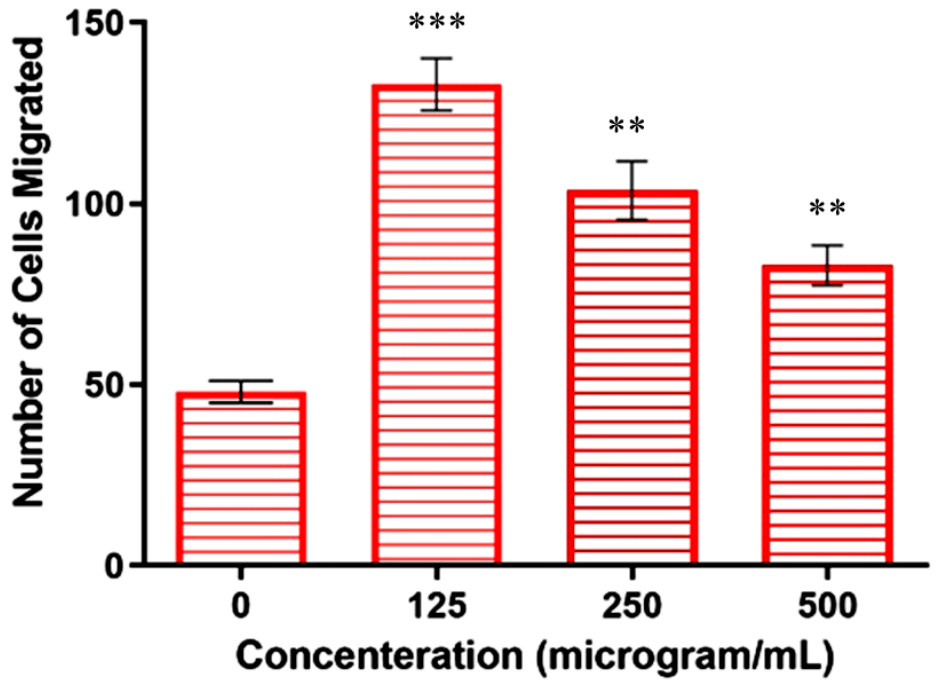
Figure 6. Copper–Schiff base complex inhibition of cell (A549) migration according to concentration as compared to control. Data are expressed as the mean ± SD ( n = 3). ** p < 0.01; *** p < 0.001 when compared to control.